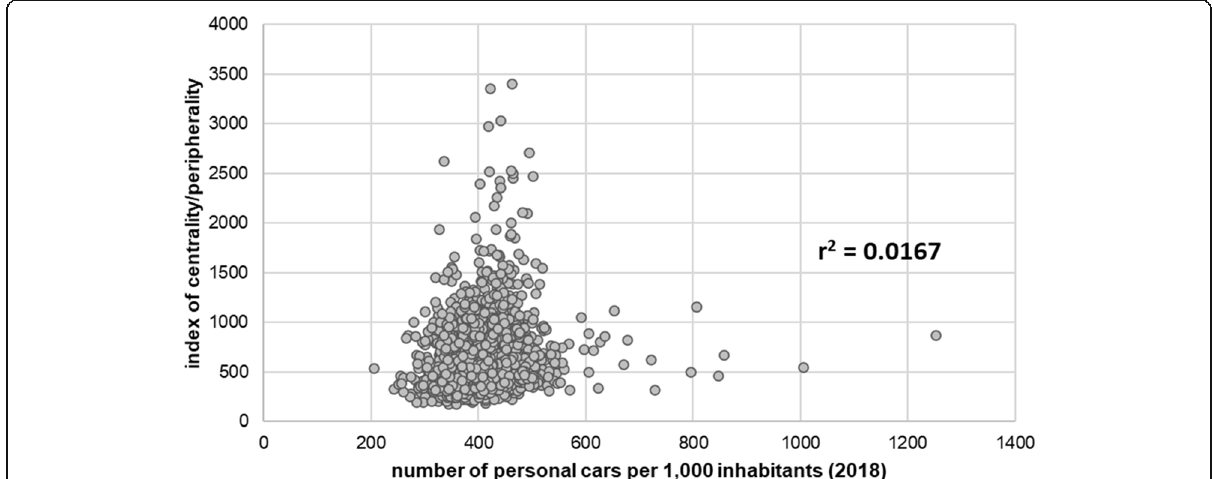
Fig. 2 Relationship between the centrality/peripherality index and car ownership. Source: own elaboration based on the Ministry of Finance and Central Vehicle Agency